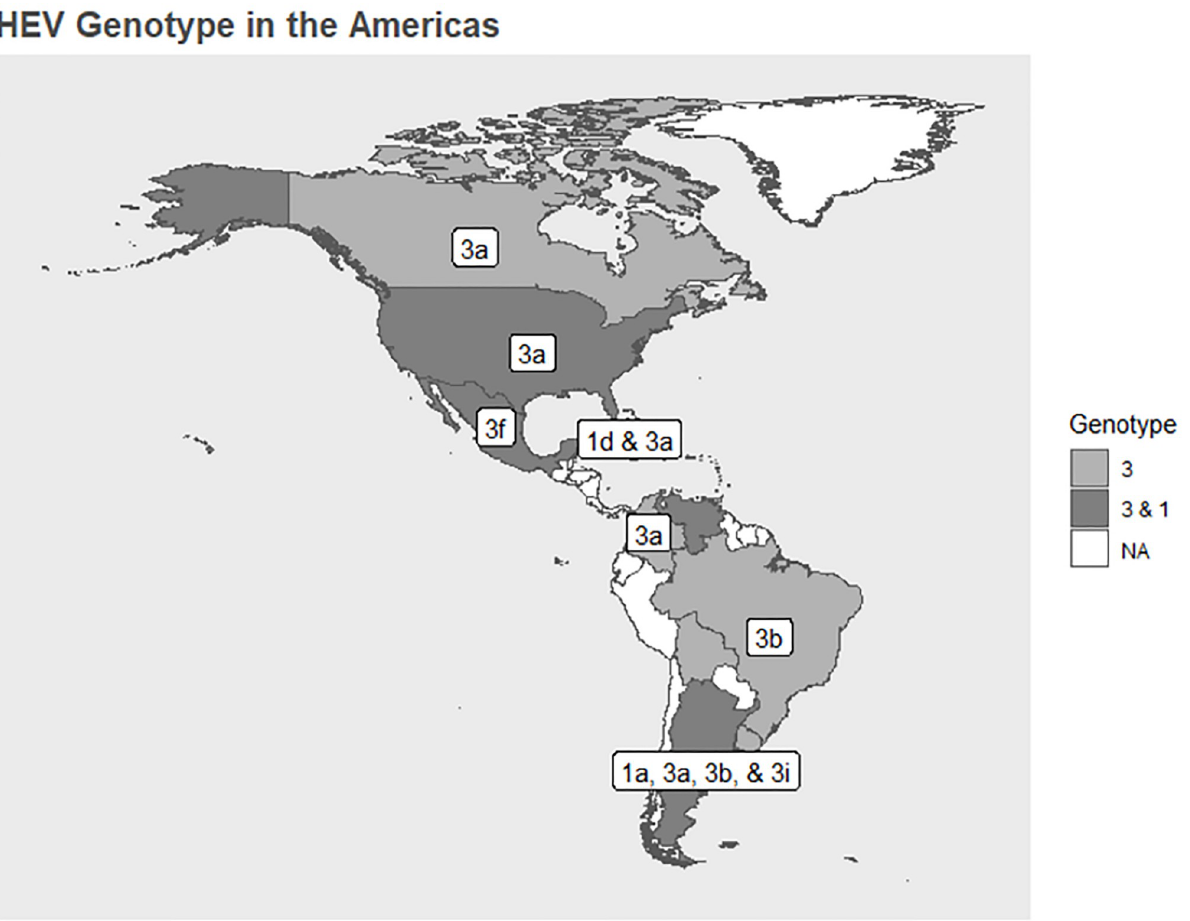
Fig 3. HEV genotype distribution in the Americas according to the included